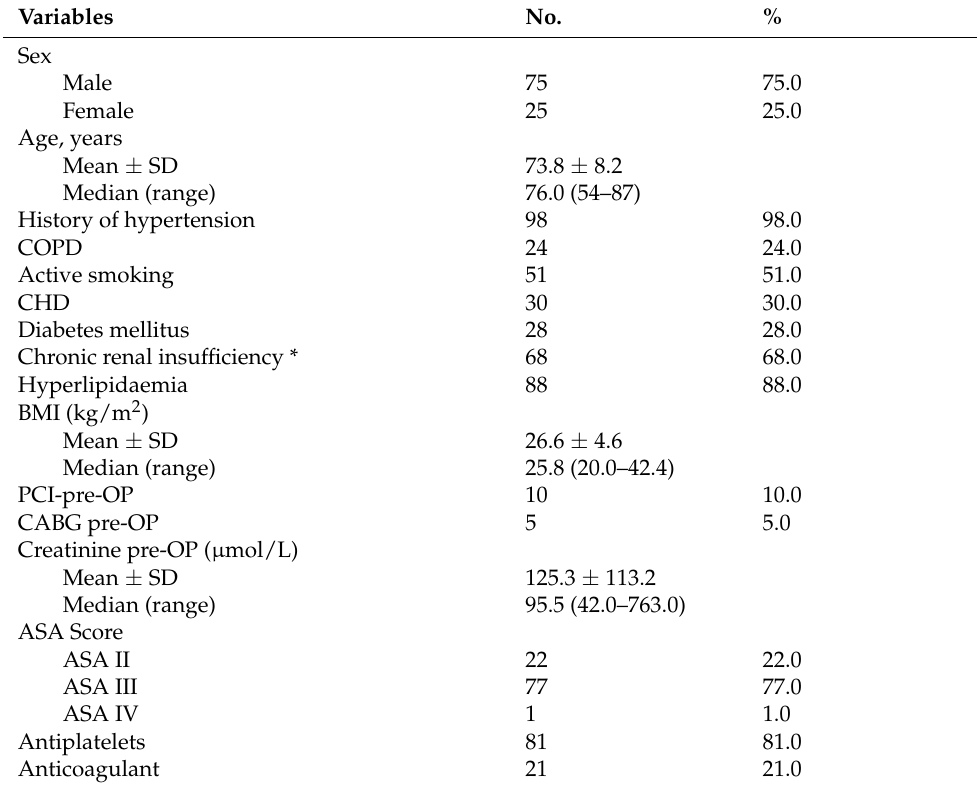
Table 1. Patient